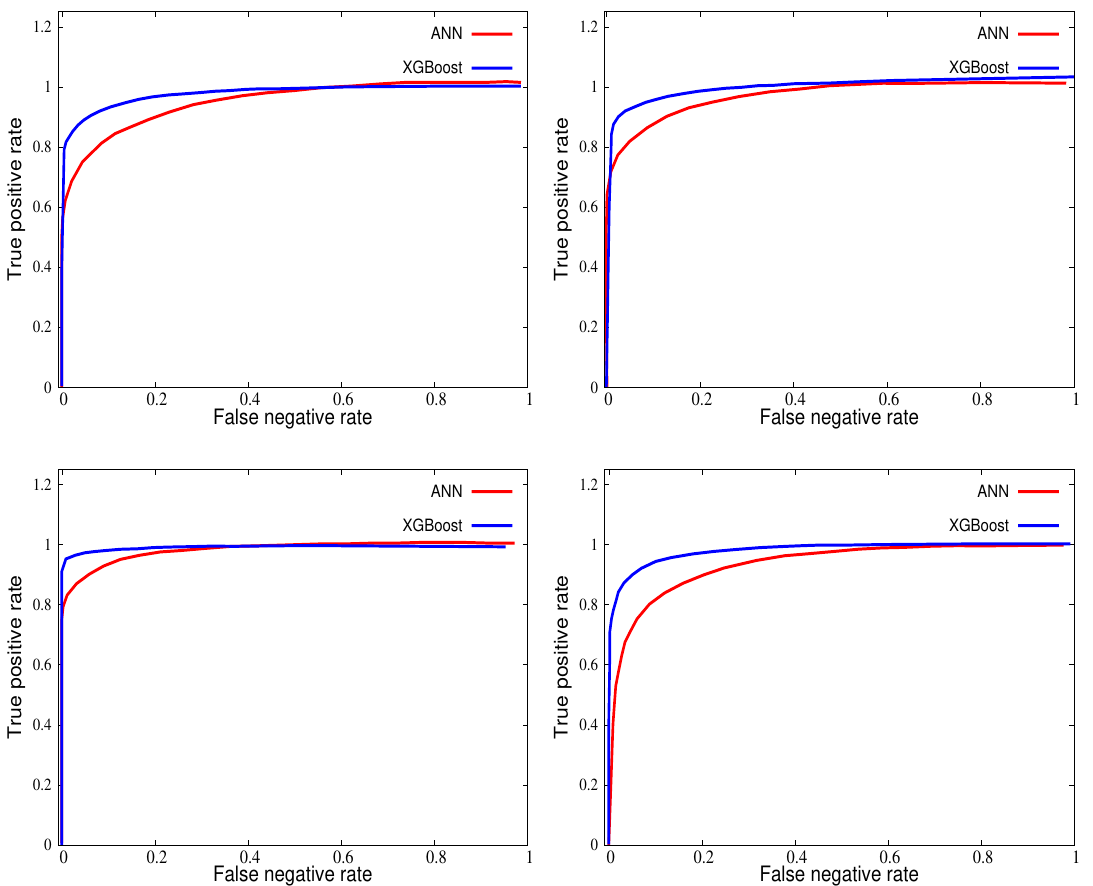
Figure 20 . ROC curves of BP1 (top left), BP2 (top right) and BP3 (bottom left) and BP4(bottom right) in case II with ANN and XGBoost.